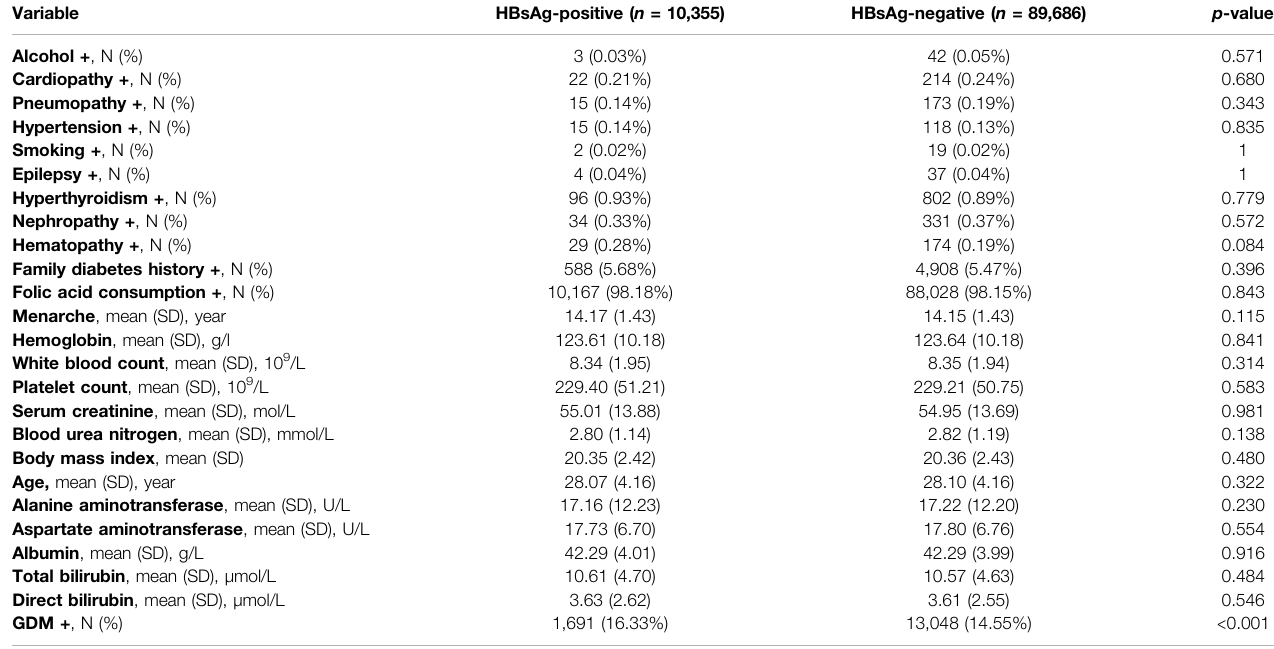
TABLE 1 | Baseline characteristics in HBsAg-negative and -positive groups. Variable HBsAg-positive ( n = 10,355)